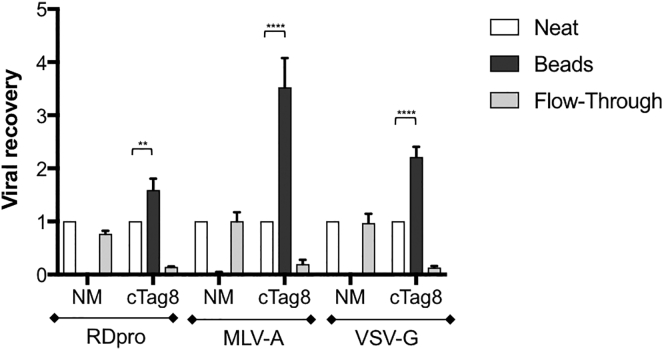
Purification of cTag8-Modified LVs in an Envelope-Independent MannerThawed NM LVs and cTag8 LVs pseudotyped with either RDpro, MLV-ampho, or VSV-G glycoproteins were incubated with streptavidin Dynabeads for 1 hr at room temperature. Dynabeads were immobilized by magnetic capture, and flow-through fractions were collected. Streptavidin Dynabeads were then washed 4 times with cold PBS and resuspended in cold medium in the same volume as starting viral supernatants. Viral titers (international units per milliliter) of all fractions: (1) crude (Neat), (2) re-suspended magnetic beads (Beads), and (3) post-capture incubation flow-through (Flow-Through) fractions were determined by infectivity assay on 293T cells. Data represent the viral recovery of each fraction compared to corresponding total vector input and are plotted ± SD of triplicate determinations; **p ≤ 0.01; ****p ≤ 0.0001.